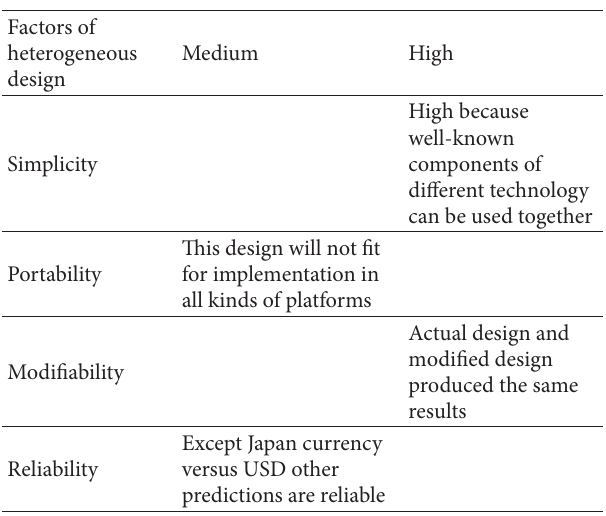
Table 1: Quality attributes of software design. Table 2: Data collected for analysis.